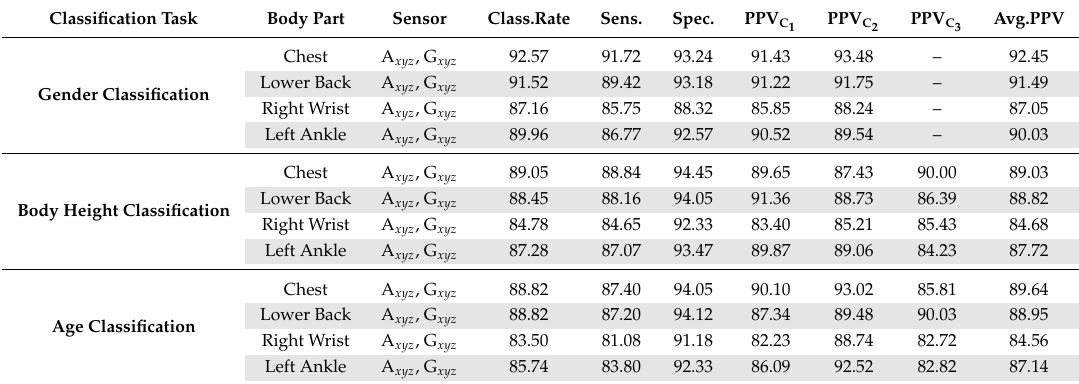
Table 6. Classification results obtained by using 10-fold cross-validation for different classification categories: gender, height and age. The results show balanced correct classification rates, sensitivity, specificity, the positive predictive value (PPV) of each class and the average PPV of all classes. Classification Task